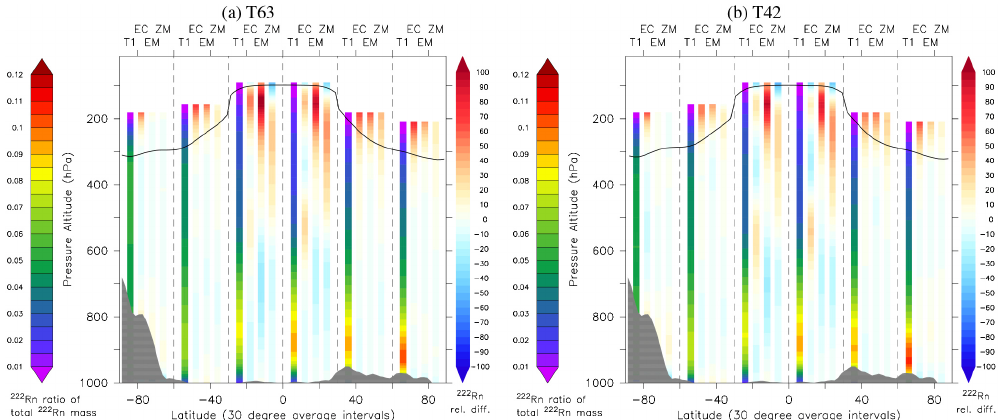
Figure 6. Zonally averaged radon ratios of the total atmospheric radon mass. The vertical axis depicts the pressure altitude and each bar represents an average over 30 ◦ latitude (90 ◦ S to 60 ◦ S, 60 ◦ S to 30 ◦ S, etc.) for all simulations indicated in the top row of the graphs. The first bar in each bin shows the ratio for the T1 REF simulations using the colour bar on the left side. The other three bars in each bin indicate the relative difference in % to the Tiedtke simulations using the colour scale on the right-hand side of the panel. The black solid line illustrates the mean tropopause height of the REF simulations and the grey shaded area the zonal mean orography.